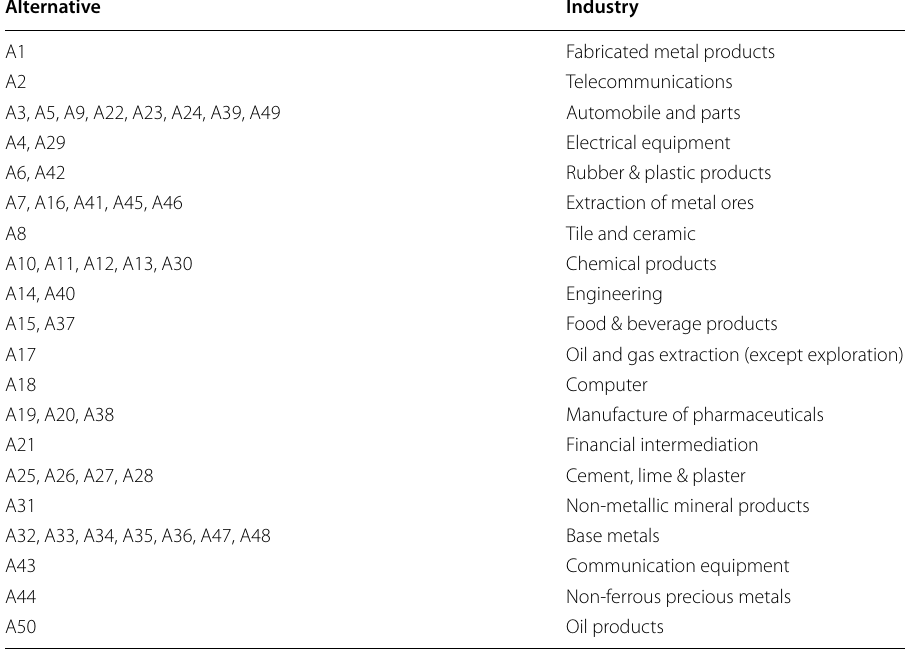
Table 4 Stock industry